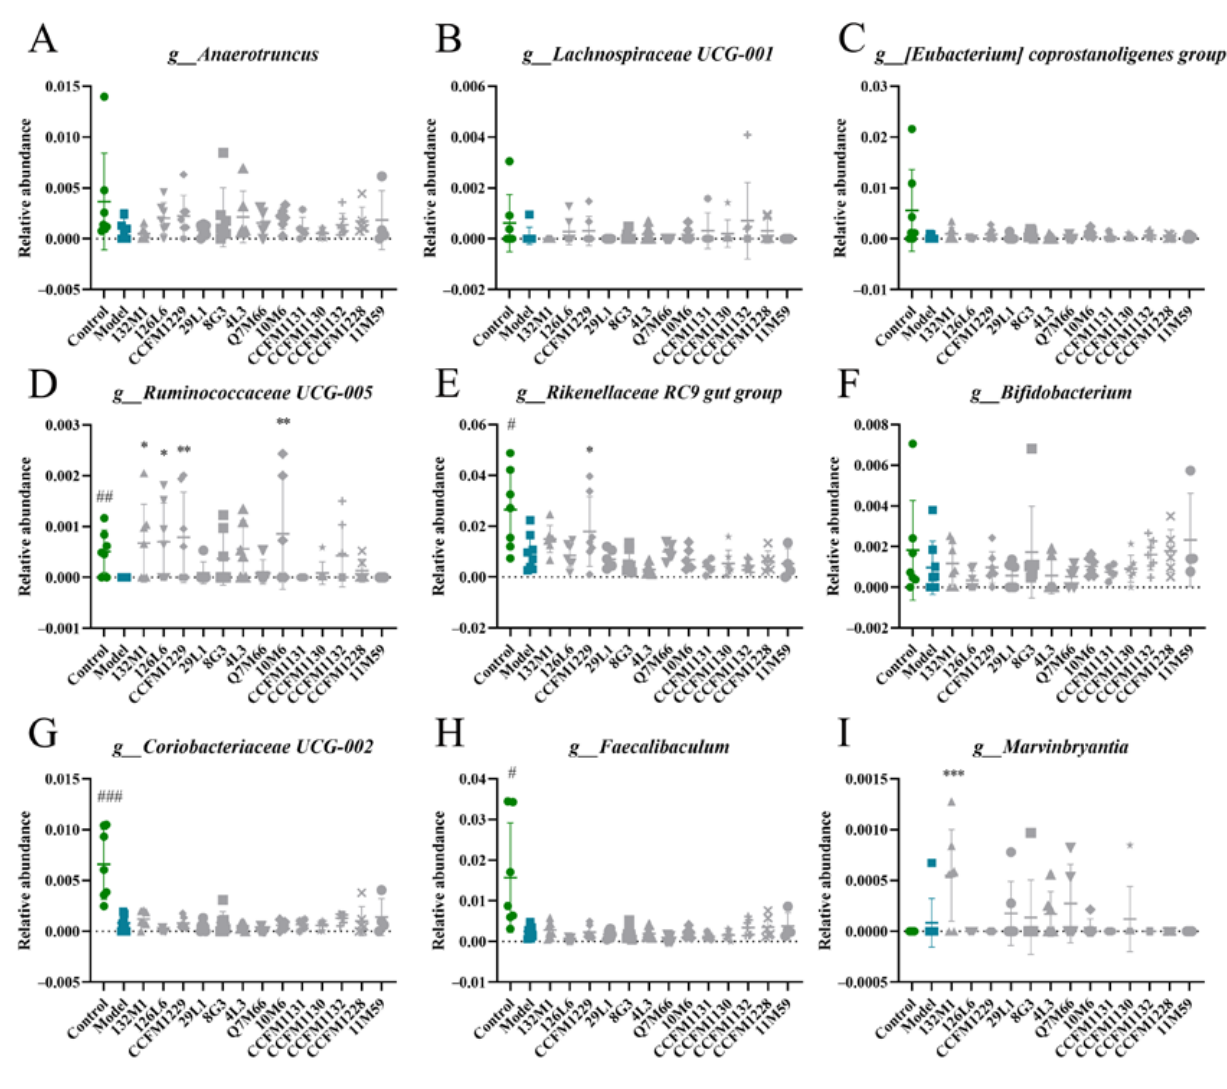
Figure 9. Relative abundance of bacteria associated with xanthine oxidase activity in cerebral cortex. ( A ) Anaerotruncus . ( B ) Lachnospiraceae UCG-001 . ( C ) [Eubacterium] Coprostanoligenes group. ( D ) Ruminococcaceae UCG-005. ( E ) Rikenellaceae RC9 gut group. ( F ) Bifidobacterium . ( G ) Coriobacteriaceae UCG-002. ( H ) Faecalibaculum . ( I ) Marvinbryantia . # p < 0.05; ## p < 0.01; ### p < 0.001; * p < 0.05; ** p < 0.01; *** p < 0.001 comparing with depression group.